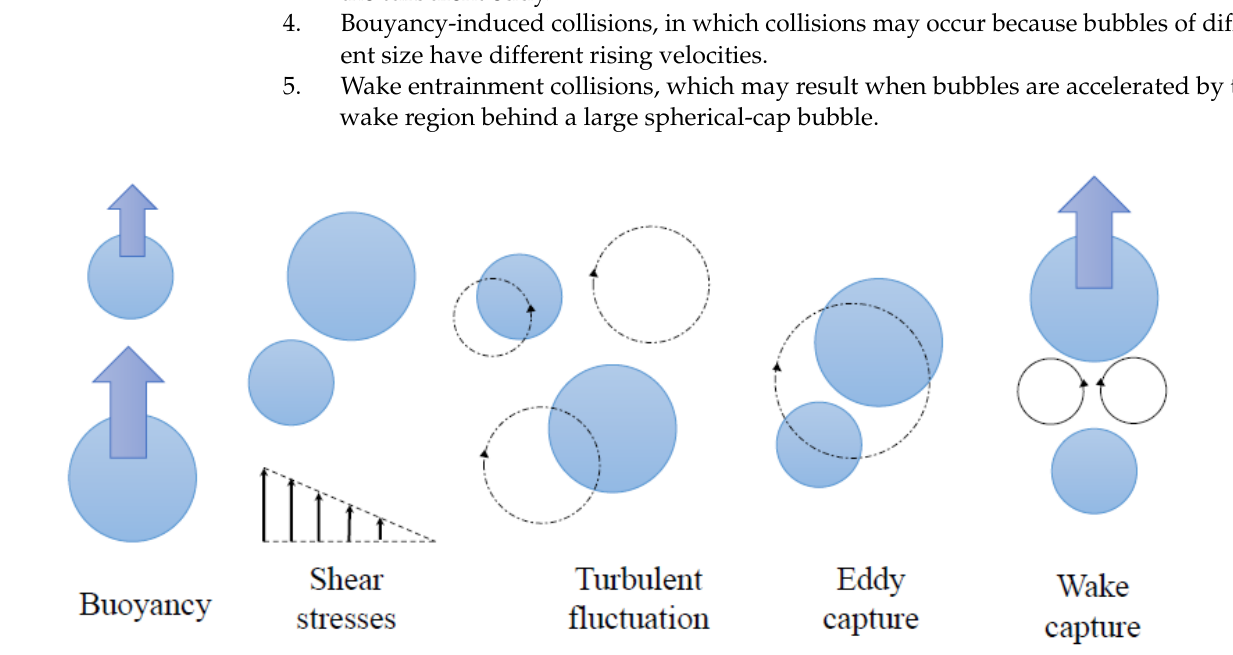
Figure 12. Coalescence